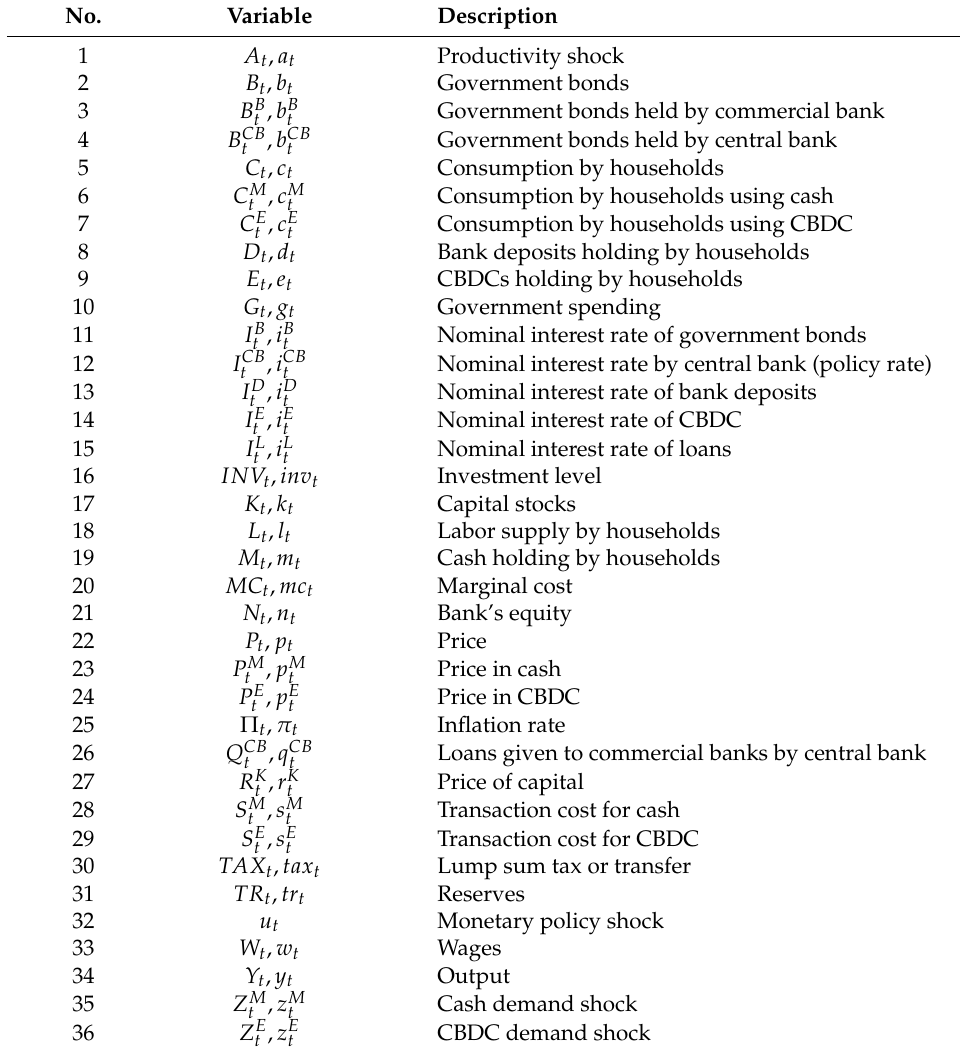
Table A1. The description of